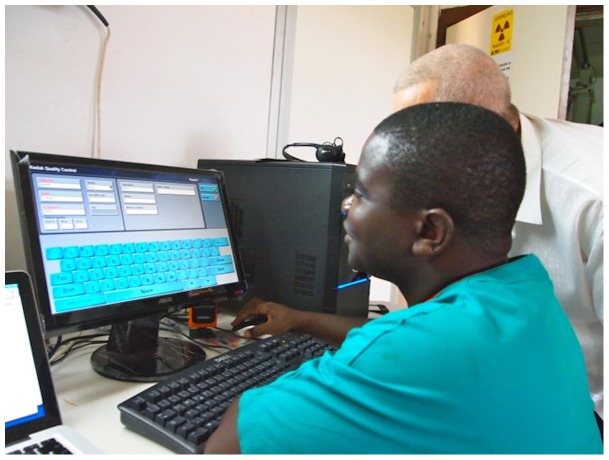
A technician during the training.